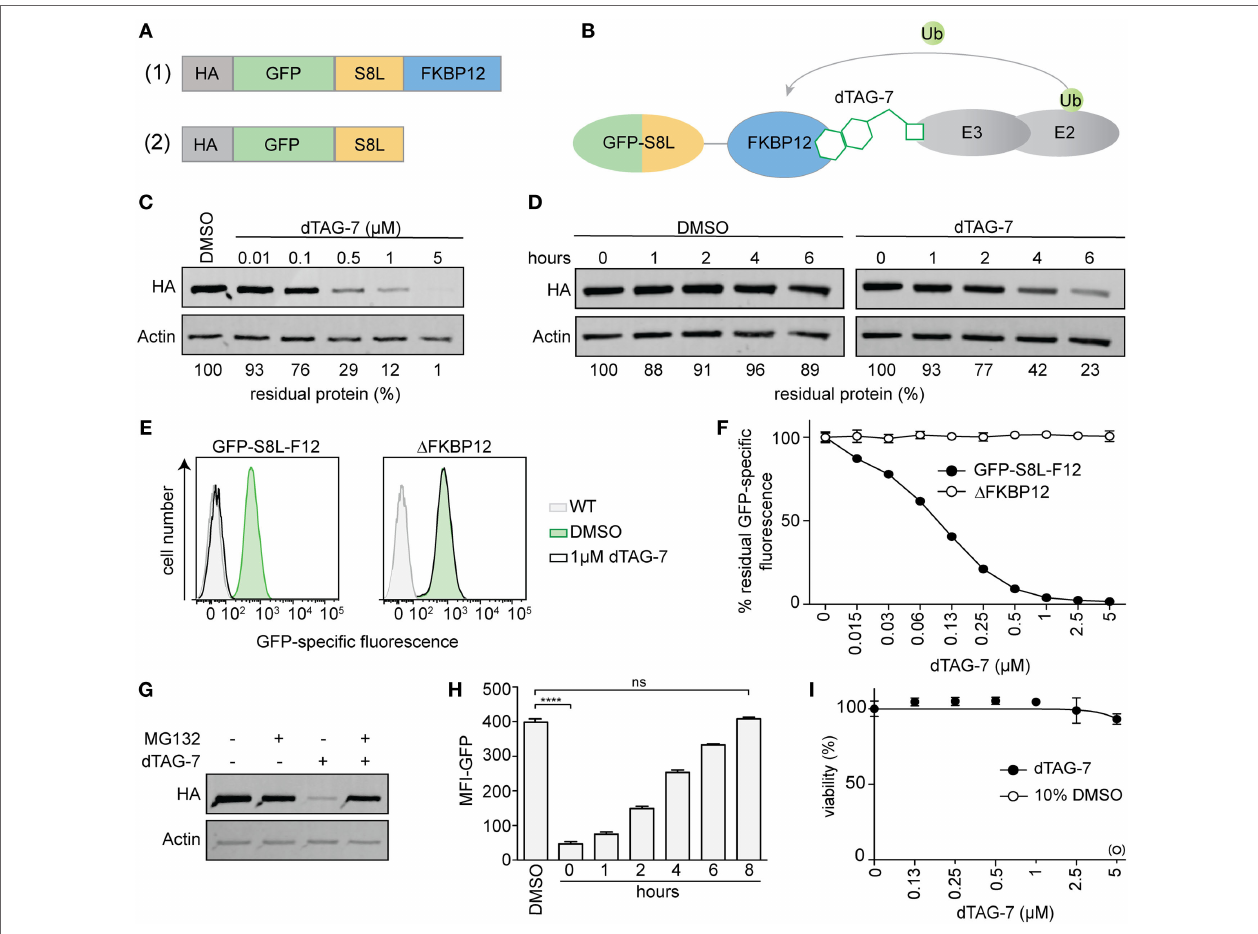
FigUre 1 | Generating a model system to study degradation tag (dTAG)-7-dependent antigen presentation. (a) Illustration of the model antigen GFP-S8L-F12 (1) and the control construct Δ FKBP12, lacking the dTAG (2). (B) Schematic illustration of the mechanism of dTAG-7-mediated antigen degradation. The dTAG-7 molecule shown does not reflect the original structure. (c) GFP-S8L-F12-expressing BMC-2 cells were treated with indicated concentrations of dTAG-7 or 0.1% DMSO as control and 18 h later the residual % of protein was assessed by anti-HA western blot analysis. Bands were quantified compared to the DMSO control and normalized to actin expression using ImageJ. (D) Antigen expressing BMC-2 cells were treated with 100 µg/mL of the translation inhibitor cycloheximide for indicated time points and 1 µM dTAG-7, or 0.1% DMSO as a control, was added to alter antigen stability. Residual amount of protein in % was analyzed by anti-HA western blot and quantified relative to actin expression using ImageJ. (e,F) Antigen- or Δ FKBP12-expressing BMC-2 cells were cultured in the presence of increasing concentrations of dTAG-7 or 0.1% DMSO as control (0 µM) for 18 h and GFP-specific fluorescence was quantified by flow cytometry. (e) Representative histograms comparing GFP-specific fluorescence with or without 1 µM dTAG-7 treatment to wild-type BMC-2 cells (WT). (F) The graph indicates % residual GFP-specific fluorescence normalized to the mean fluorescence intensity (MFI) measured with 0 µM dTAG-7, for each construct, respectively. Values are shown as the mean ± SD from triplicate measurements. (g) GFP-S8L-F12-expressing BMC-2 cells were cultured for 6 h in the presence or absence of 1 µM dTAG-7 and/or 10 µM of the proteasome inhibitor MG132. Afterward, GFP-S8L-F12 levels were evaluated by anti-HA western blot, using actin expression as control. (h) GFP-S8L-F12-expressing BMC-2 cells were treated with 1 µM dTAG-7 (0 h) or 0.1% DMSO as control for 18 h. Next, dTAG-7 was washed off and GFP-specific fluorescence (MFI-GFP) was analyzed by flow cytometry at indicated time points. Values are shown as the mean ± SEM from triplicate measurements. (i) ATP-based cell viability measurement (CellTiter-Glo) of GFP-S8L-F12-expressing BMC-2 cells treated for 18 h with indicated concentrations of dTAG-7 or 10% DMSO as a positive control for the induction of cell death. Values are shown as the mean ± SEM from triplicate measurements. Representative results from three (c,D,g–i) or two (e,F) independent experiments are